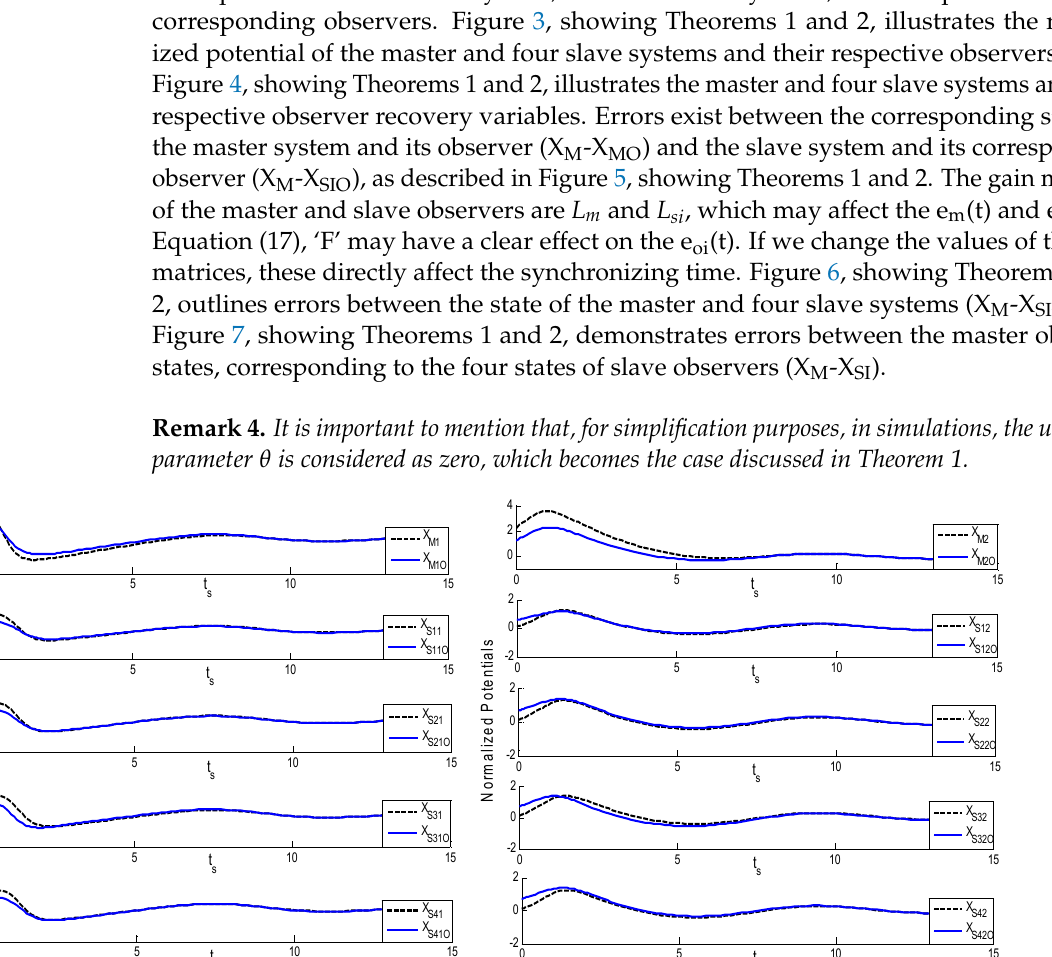
( b ) Figure 3. ( a ) Normalized potential of the master and four slave systems; ( b ) the respective observers of Theorems 1 and 2.